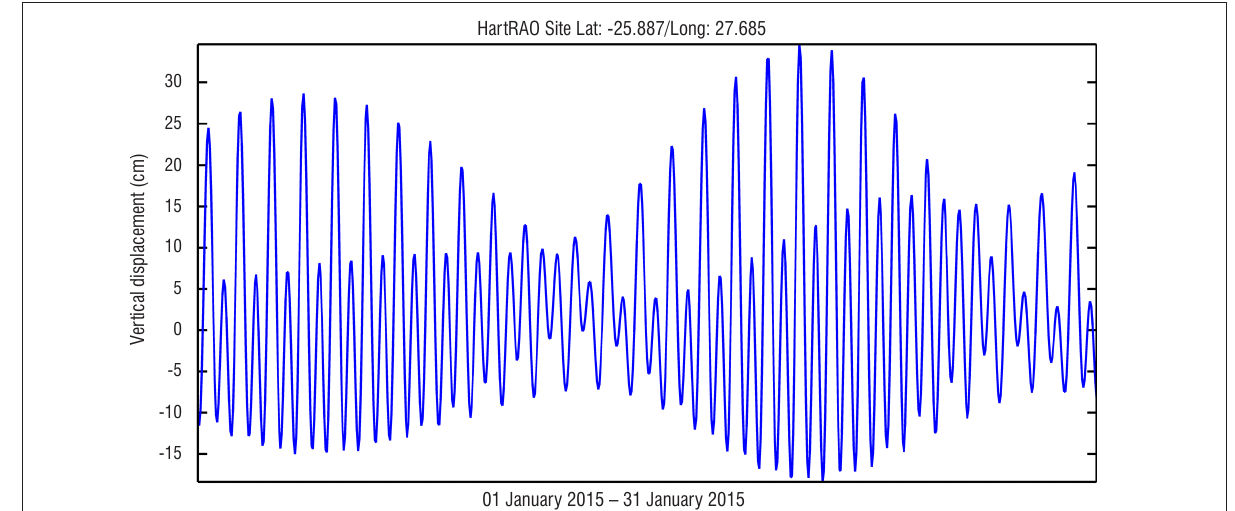
Station vertical displacement for the HartRAO site, simulated for the month of January